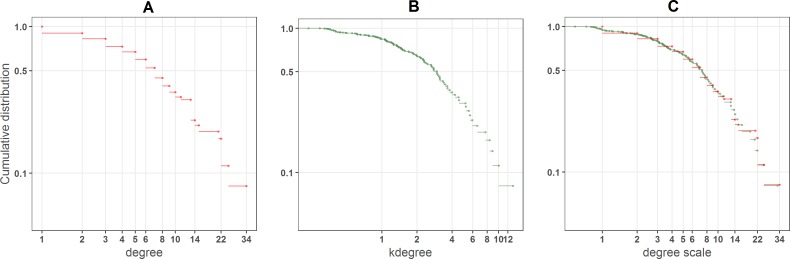
(A) Degree, (B) kdegree and (C) overimposed kdegree distributions of a big plant pollinator community in Central Los Andes, Chile (Arroyo, Primack & Armesto, 1982).